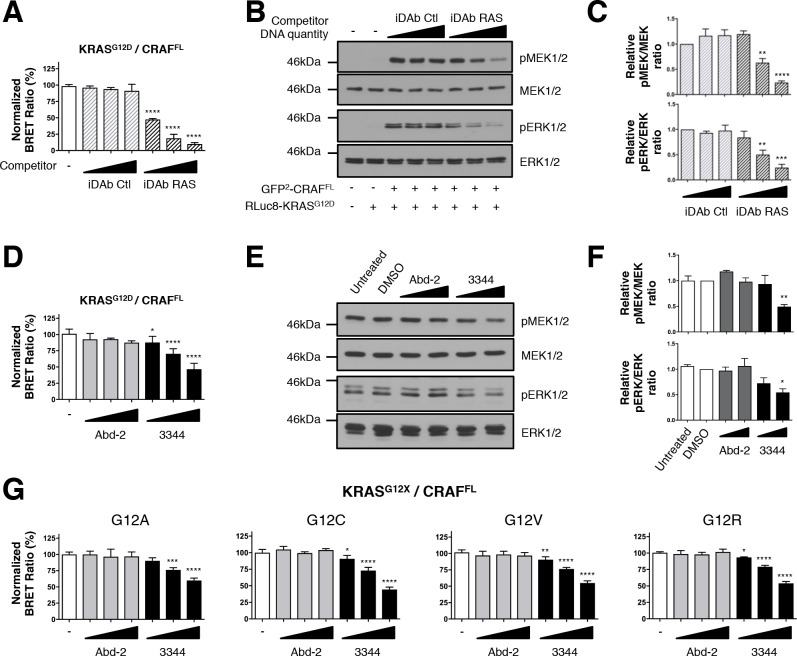
BRET biosensors of KRASG12 mutants and full-length CRAF are inhibited by compound 3344.A biosensor for the full-length CRAFS257L (CRAFFL) protein was made and tested for interaction with mutants of KRAS glycine 12. For A and B, the plasmids expressing BRET pair KRASG12D/CRAFFL was transfected into HEK293T cells and competed with iDAb expression as indicated; the BRET ratios are shown in A and western blot data in B. The iDAb RAS inhibition of phosphorylation of ERK and MEK signals are quantified in C. The β-actin loading control, iDAbs and BRET pair expression controls are shown in Figure 2—figure supplement 1. In D, the BRET ratio of KRASG12D/CRAFFL interaction was measured in the presence of an increasing dose of compound 3344. This induces a dose-dependent decrease of MEK and ERK kinase phosphorylation (E) after cells expressing the KRASG12D/CRAFFL biosensor pair were treated 20 hr with DMSO, 10 and 20 μM of Abd-2 and 3344 compounds or not treated (untreated lane). The β-actin loading control and BRET pair expression controls are shown in Figure 2—figure supplement 1. Quantification of the relative levels of pMEK1/2 and pERK1/2, normalized to total MEK1/2 and ERK1/2 respectively, are shown in F. The RAS biosensor toolkit includes KRAS G12A, G12C, G12V and G12R, in addition to KRAS G12D. In G, each was expressed with CRAFFL and BRET ratios determined at 0, 5, 10 and 20 μM Abd-2 or 3344. Statistical analyses in C were performed using a one-way ANOVA followed by Sidak’s post-hoc tests and in A, D, F and G using a one-way ANOVA followed by Dunnett’s post-tests (*p<0.05, **p<0.01, ***p<0.001, ****p<0.0001). Each experiment was repeated twice (E–F), three times (B–D), four times (A) or five times (G). Where error bars are presented, they correspond to mean values ± SD of biological repeats (A, D, G) or correspond to mean ±SEM of biological repeats (C, F). See also Figure 2—figure supplement 1.